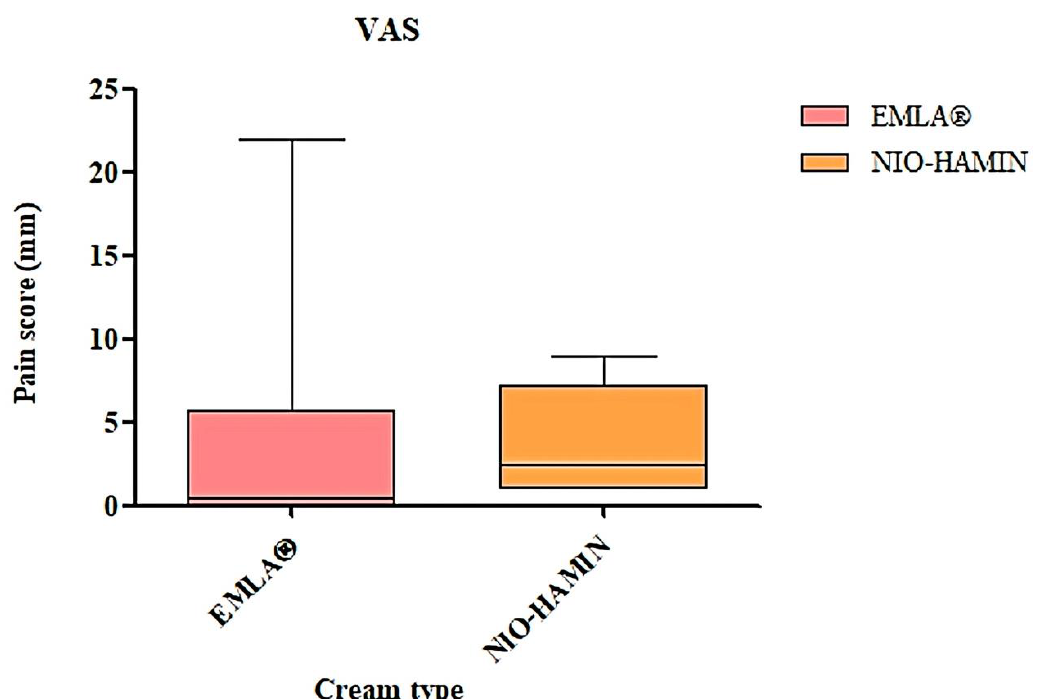
Figure 10. Visual analogue score (VAS) for NIO-HAMIN F1-C emulgel compared to EMLA ® cream. Values are presented as pain score vs. treatment ( n = 40, p < 0.05).